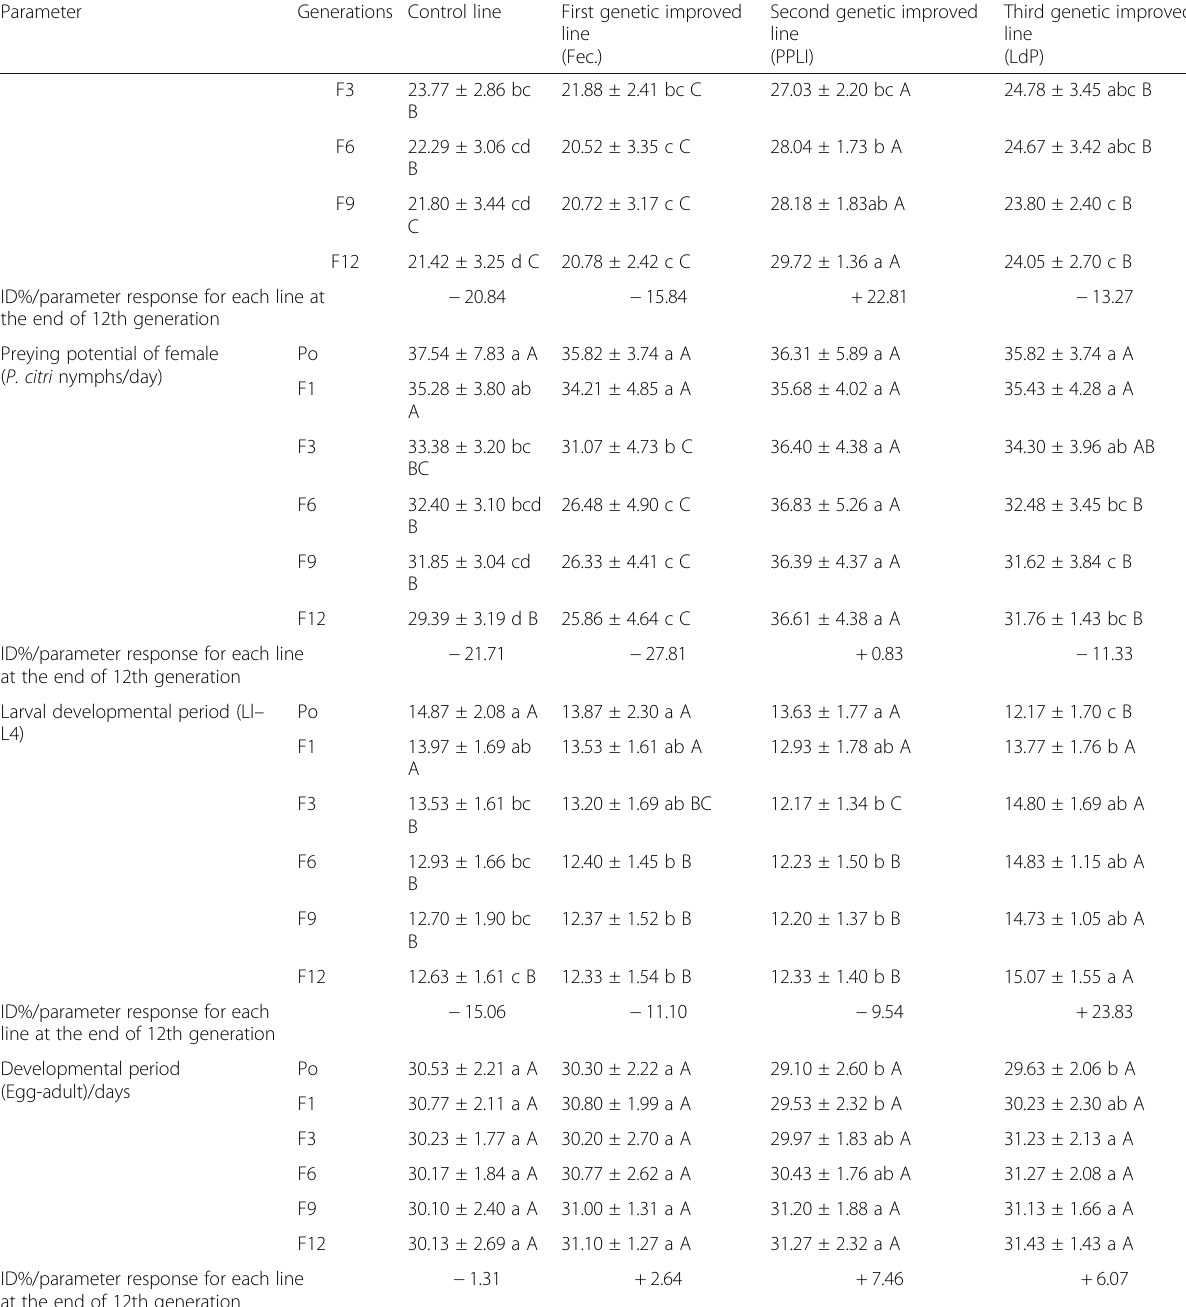
Table 1 Changes in morphobiological parameters (mean ± SD) of the predator C. montrouzieri for 12 inbreeding generations using three genetic improved lines